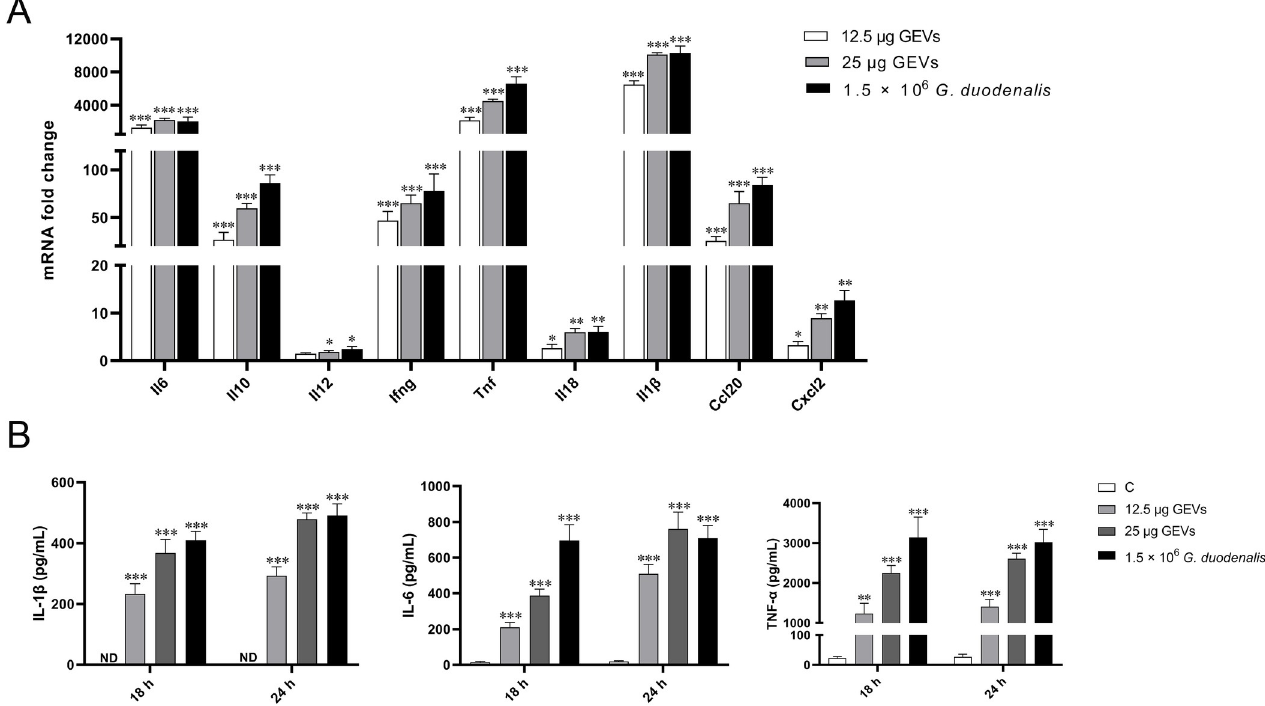
Fig 3. GEVs induced inflammatory cytokines transcription and secretion in murine peritoneal macrophages. (A) Cells were incubated with 12.5 μ g/mL or 25 μ g/mL of GEVs for 12 h, the mRNA levels of inflammatory cytokines, including Il6, Il10, Il12, Ifng, Tnf, Il18, Il1 β , Ccl20 and Cxcl2 in cells was measured using qPCR assays. (B) Cells were were incubated with 12.5 μ g/mL or 25 μ g/mL of GEVs for 18 h and 24 h, supernatants were collected for TNF- α , IL-6, and IL-1 β determination using ELISA assays. G . duodenalis (1.5 × 10 6 parasites/mL) treated groups were used as positive control. Equal volume PBS-treated group was used as negative control. All experiments were performed three times with three technical replicates and data are mean ± SEM. � p < 0.05, �� p < 0.01 or ��� p < 0.001 vs. control.